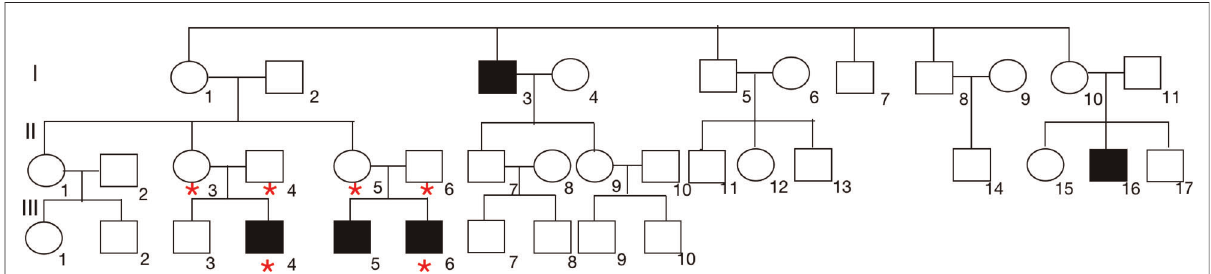
FIGURE 2 Pedigree analysis of this family. We identi fi ed 2 brothers, the proband (III-4) and the affected brother (III-6) who were admitted to our hospital, with proteinuria. The proband was diagnosed with FSGS based on kidney biopsy. The closed boxes represent the patients with proteinuria in this